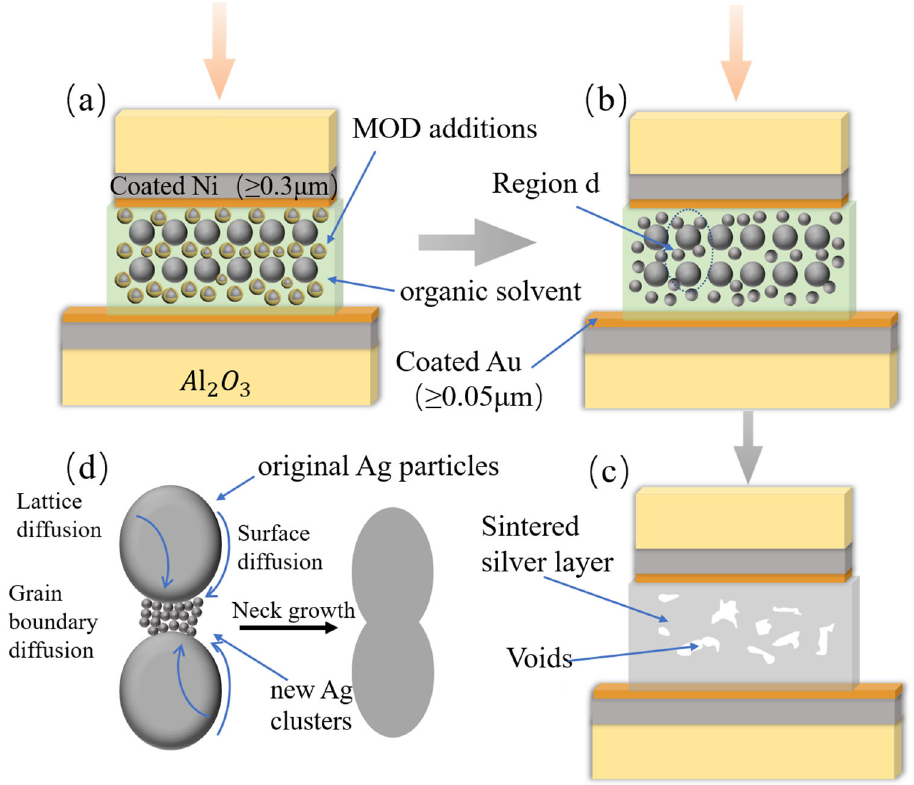
Figure 11. ( a – c ) The schematic diagram of a MOD-assisted sintering mechanism (( d ) presents an enlarged view of a specific area in ( b )).